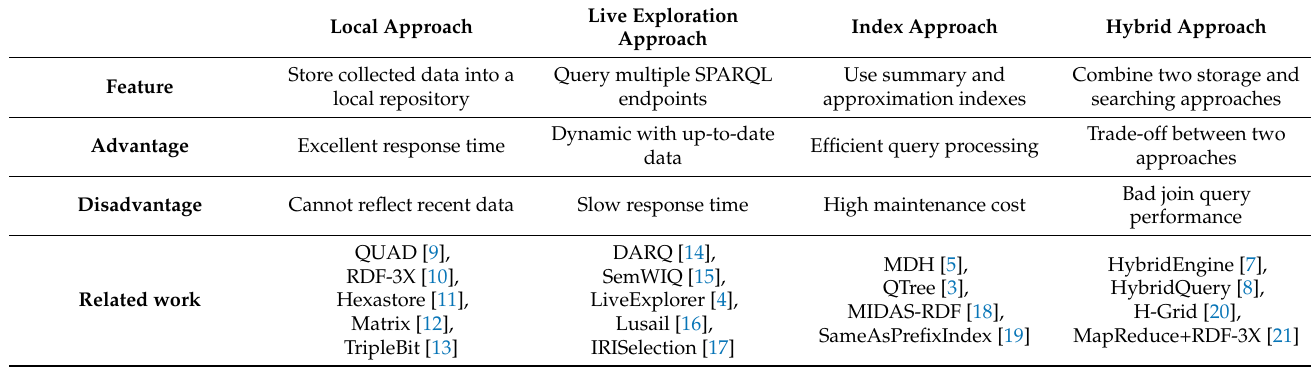
Table 1. Storage and searching